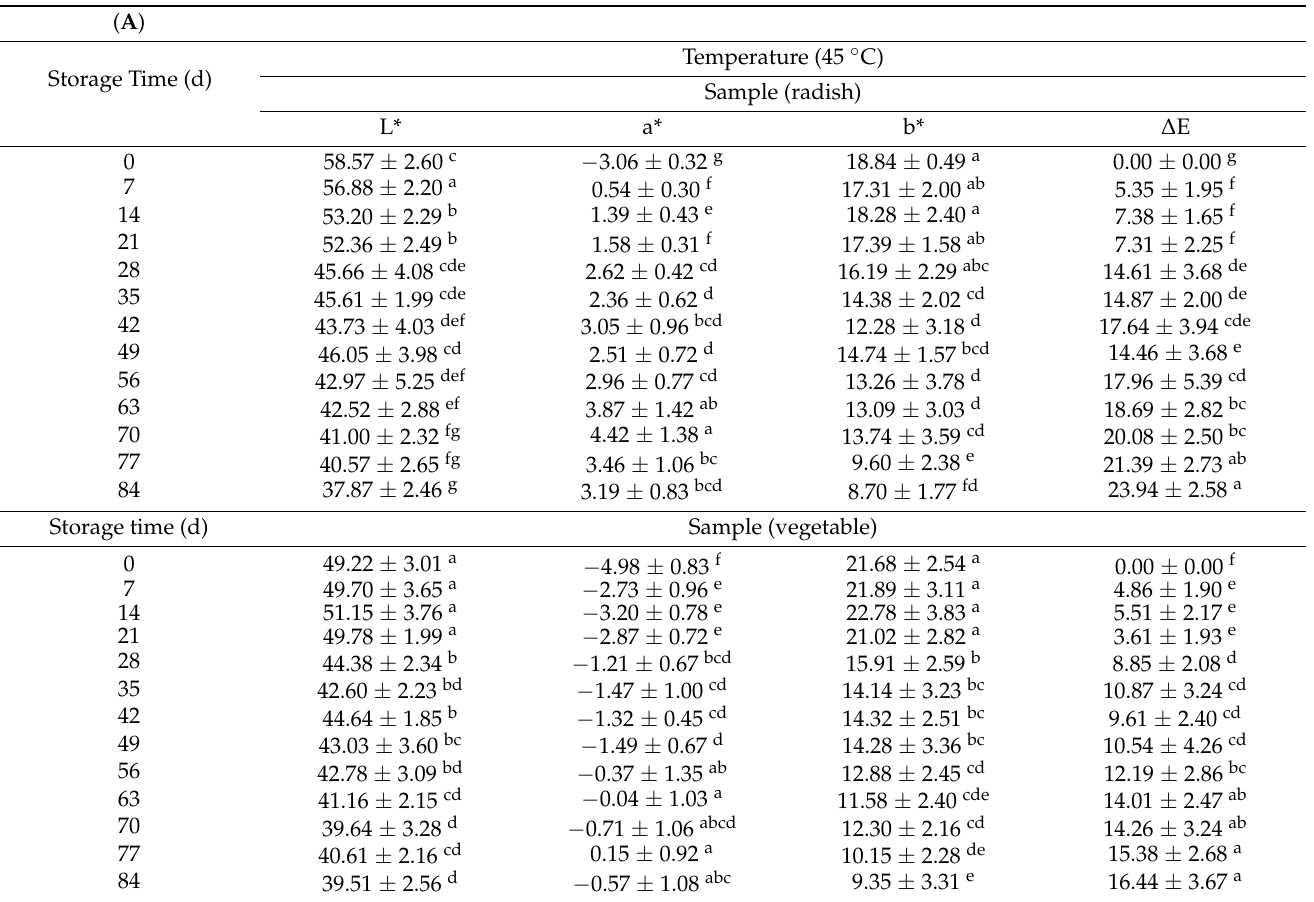
Table 3. ( A ) Color change of Sichuan sauerkraut during storage at 45 ◦ C. ( B ) Color change of Sichuan sauerkraut during storage at 35 ◦ C. ( C ) Color change of Sichuan sauerkraut during storage at 25 ◦